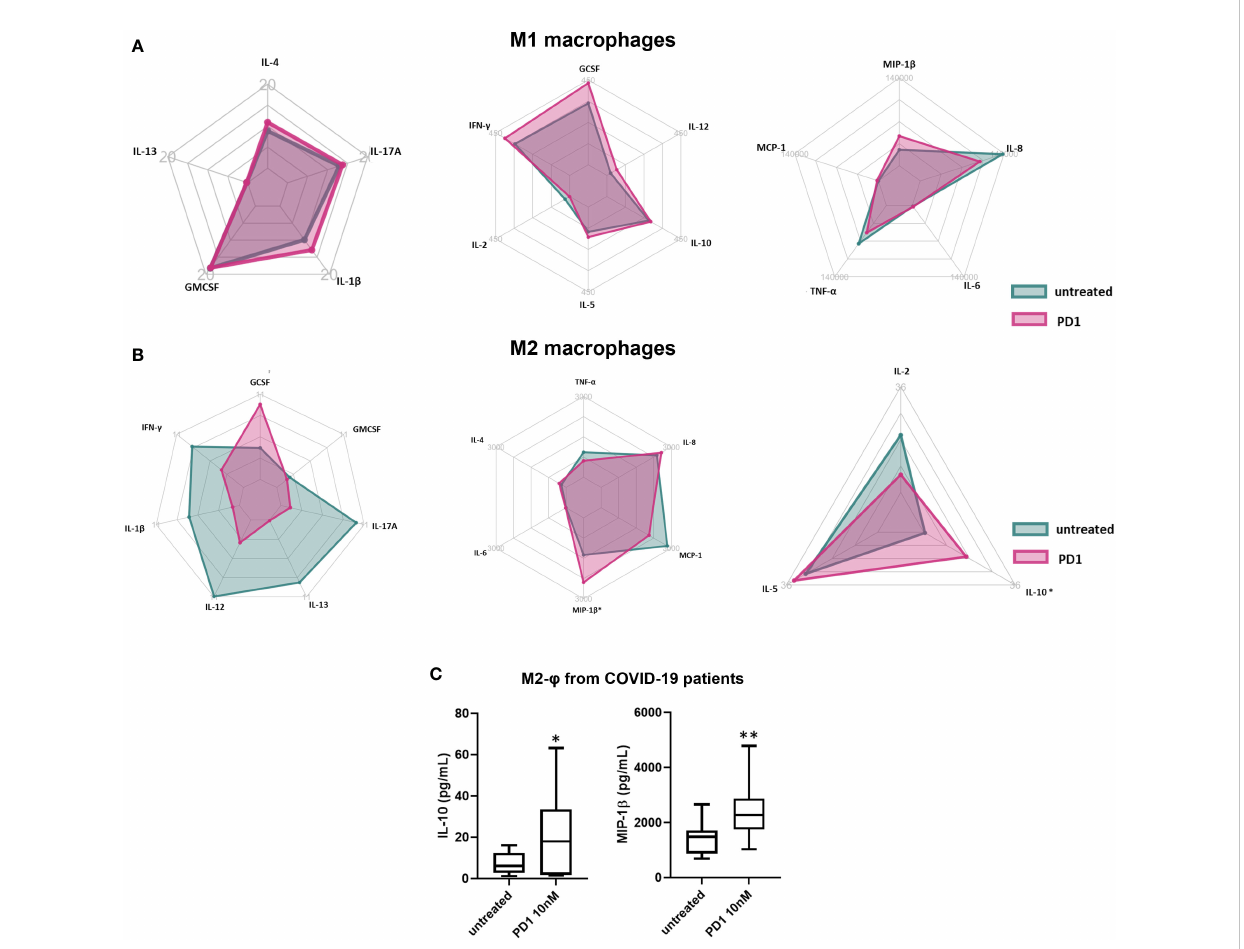
FIGURE 4 Effect of PD1 on secretion of cytokines/chemokines by macrophages from COVID-19 patients. Radar chart summarizing means of cytokines and chemokines pro fi le of M1 (A) and M2 (B) macrophages from COVID-19 patients after in vitro treatment with PD1. Green plots represent untreated cells, while pink plot PD1-treated cells. (C) Multiplex analysis of IL-10 and MIP-1 b levels in supernatants of M2 macrophages from COVID-19 patients treated with PD1. Data are reported as pg/mL and represent 12 independent experiments. IL-10, untreated vs PD1, *p= 0.03; MIP-1 b , untreated vs PD1, **p=